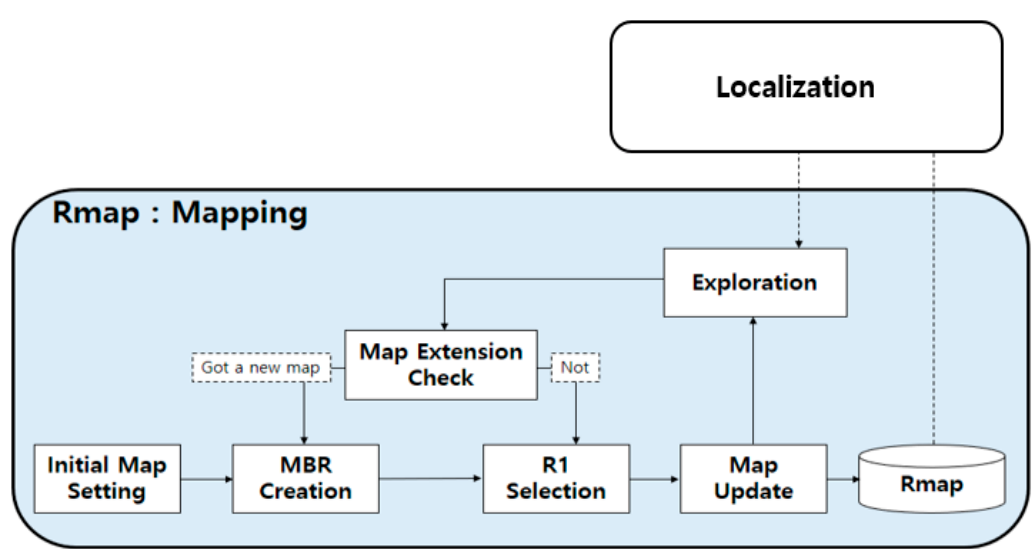
Figure 2. The framework of the Rmap scheme in which creating of Rmap is processed in mapping part of simultaneous localization and mapping (SLAM) and shares the Rmap to localization.